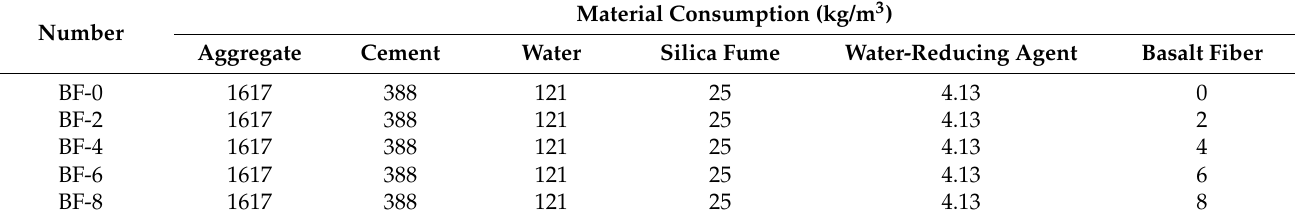
Table 6. Mix proportion of the pervious concrete.